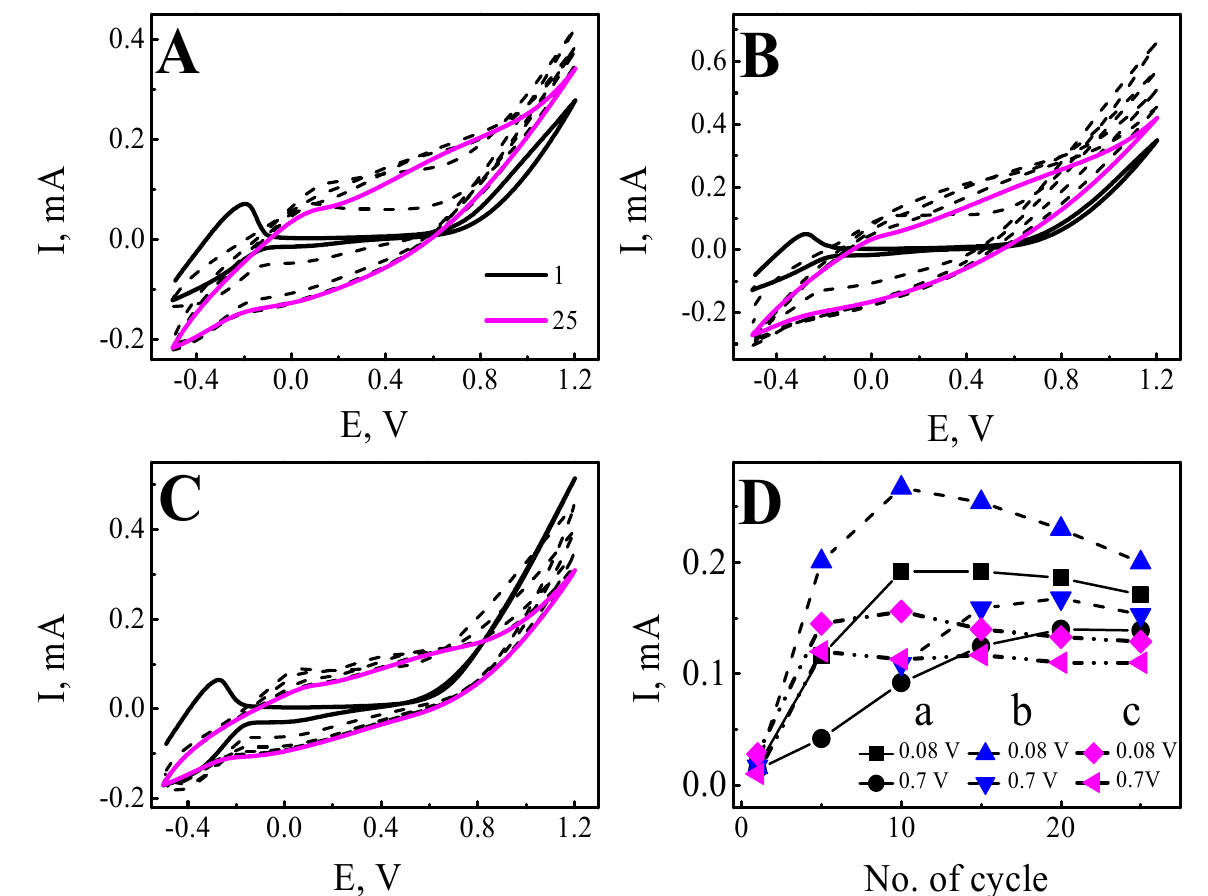
Figure 2. Electropolymerization of Ppy-PMB layers by potential cycling. Voltammograms at different cycles (1, 5, 10, 15, 20, 25): ( A )—(Ppy-PMB) Lac , ( B )—(Ppy-PMB) Suc , ( C )—(Ppy-PMB) Hep , ( D )—the width of the cycle loop in mA ( ∆ I ) was compared at potentials +0.08 V and +0.7 V. a—(Ppy-PMB) Lac ,